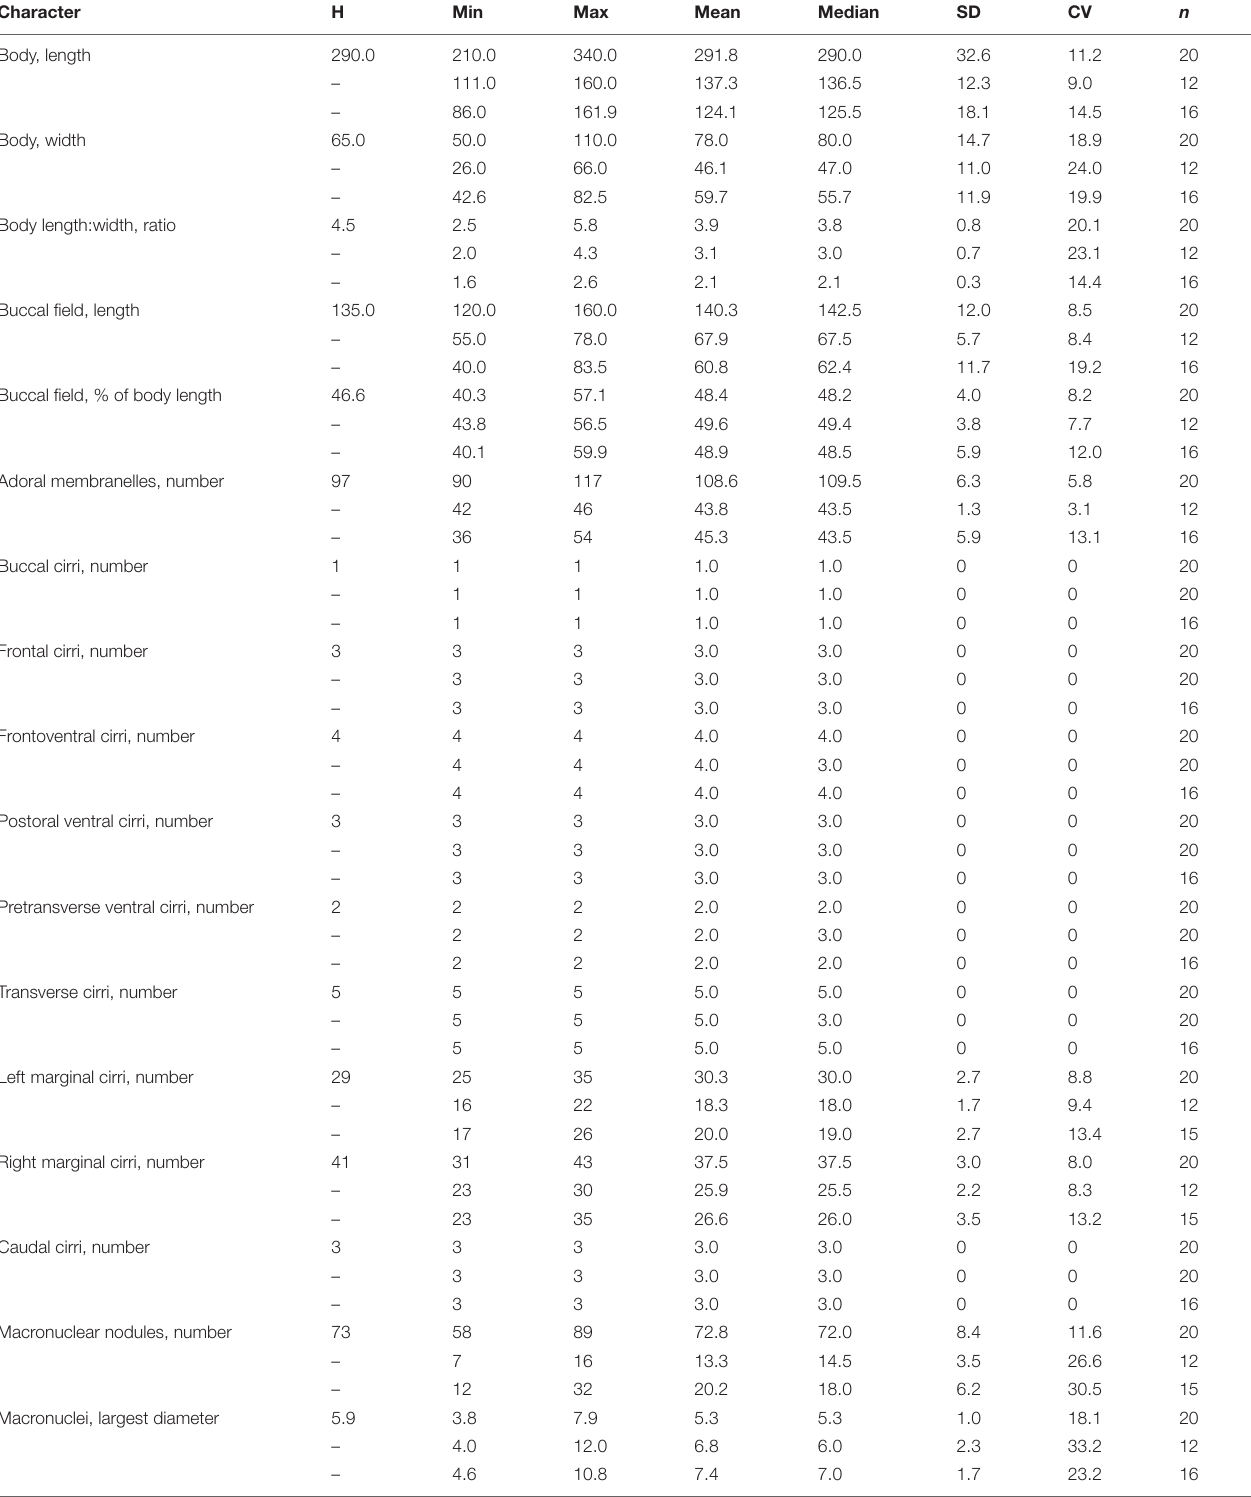
TABLE 1 | Morphometric data on Trachelostyla multinucleata spec. nov. (upper line), T. pediculiformis pop. 1 (middle line), and T. pediculiformis pop. 3 (lower line).